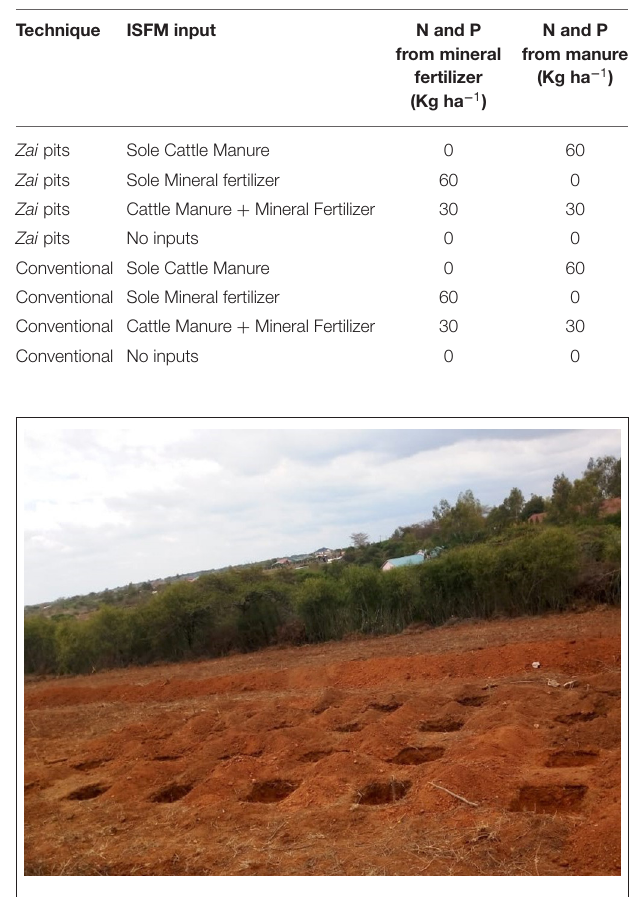
FIGURE 2 | A photo showing the Zai pit